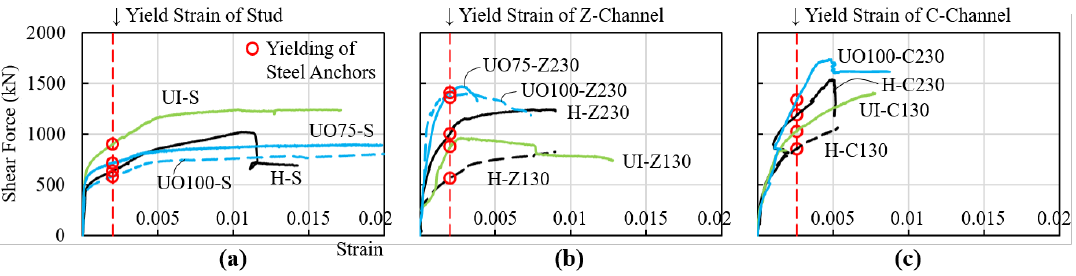
Figure 6. Shear Force—Strain Relationship of Steel Anchors: ( a ) S-group; ( b ) Z-group; ( c ) C-group. Table 3. Test Results.